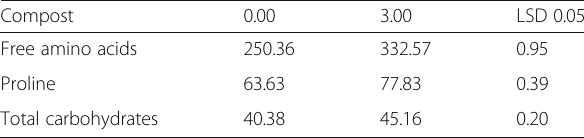
Table 11 Effect of compost addition to soil (0.00 and 3.0 tons/ fed) on free amino acids, proline (mg/100 g dry wt), and total carbohydrate percentage of flax shoots under sandy